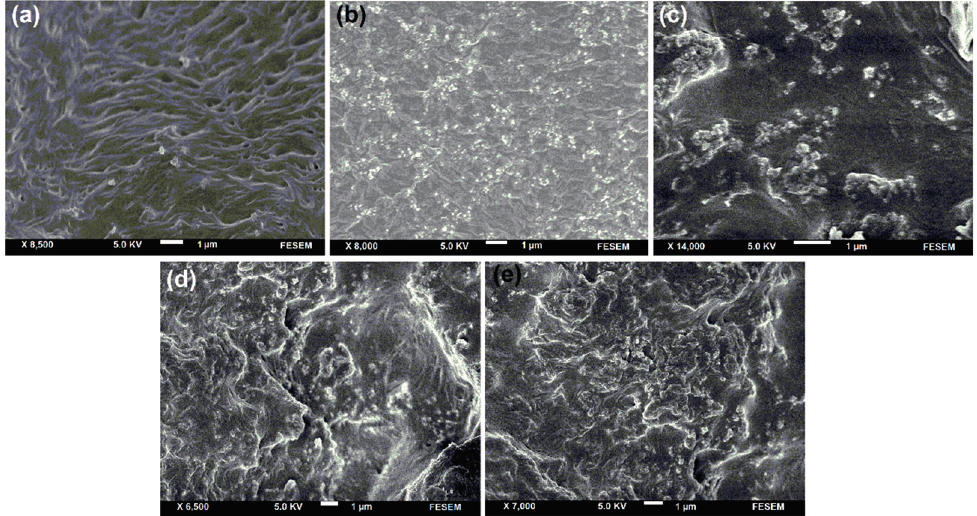
Figure 4. Scanning electron microscopy micrograph of ORS/Fe 3 O 4 /PCL-NCs in 1.0, 5.0, 15.0, 30.0 and 60.0 wt. % ( a – e